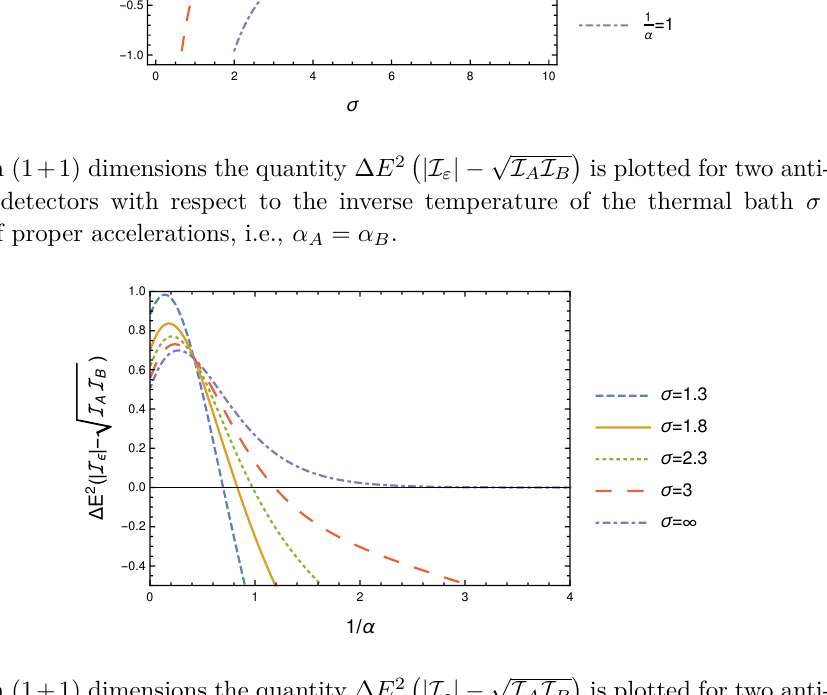
Figure 7 . In (1+1) dimensions the quantity ∆ E 2 accelerating detectors with same magnitude of acceleration for varying acceleration of the detectors α and different fixed σ